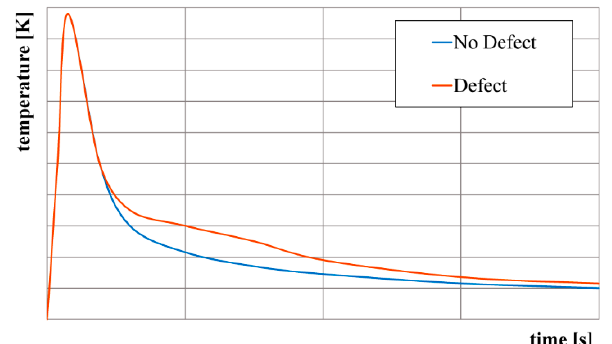
Figure 6. Surface cooling curves.